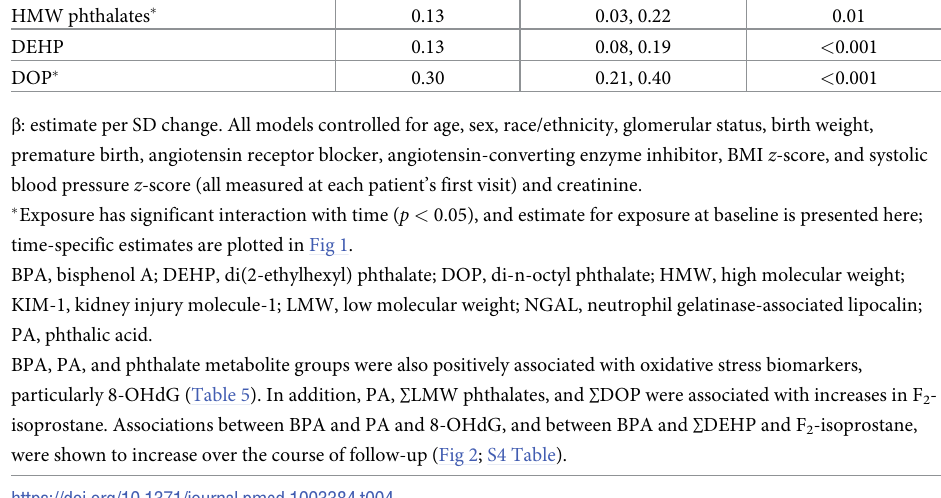
ln-KIM-1 ( N = 2,010) BPA 0.11 < 0.001 PA � − 0.01 0.87